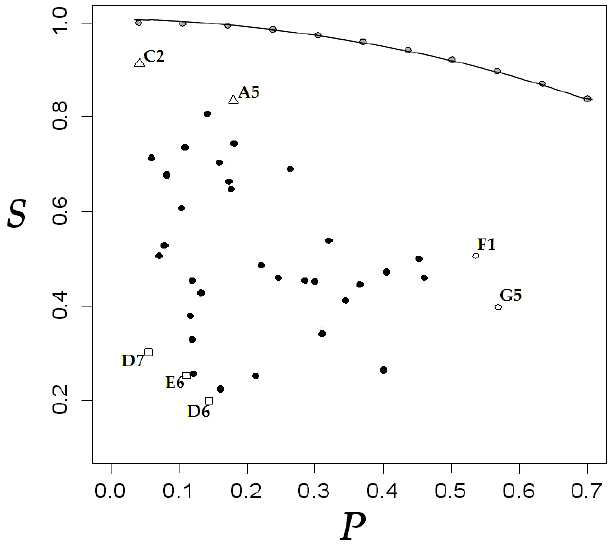
Fig. 4 . Estimates of the supporting service index relative to Atlantic Forest cover and annual per ha proportional provisioning of household subsistence needs on 38 smallholder farms in the Paraguayan Interior Atlantic